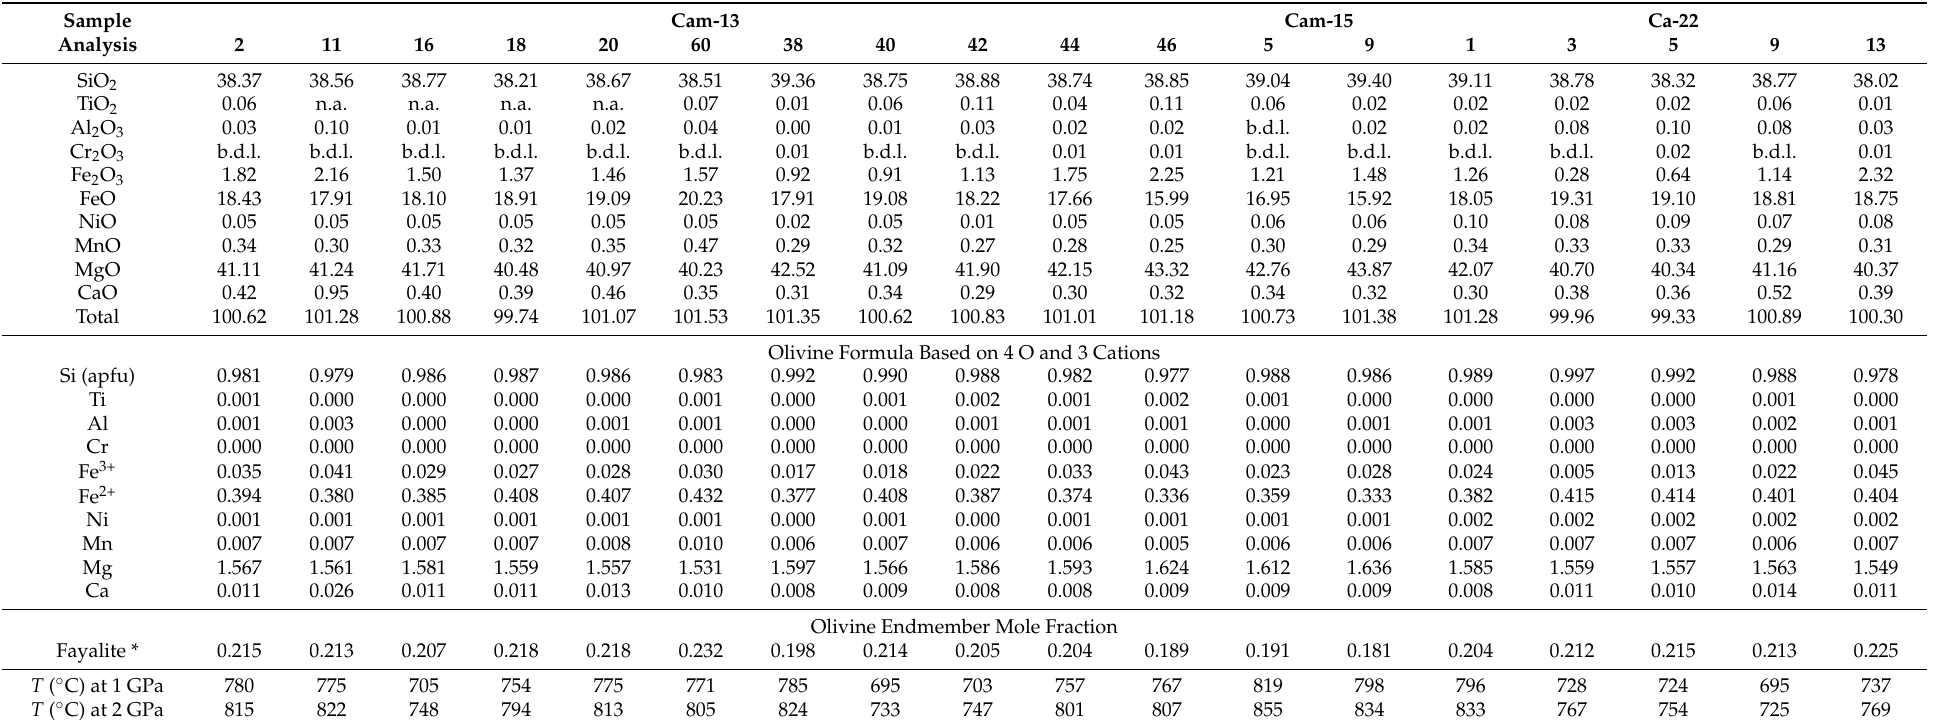
Table 5. EPMA analyses (wt% oxides) of olivines coexisting with ilmenites (Table 4) and thermobarometric data calculated after